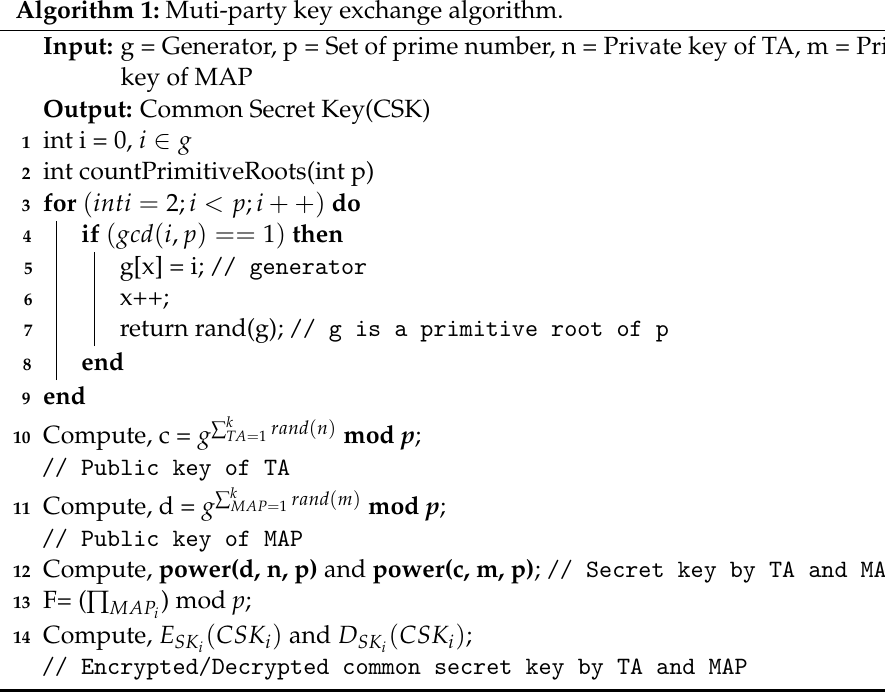
Algorithm 1: Muti-party key exchange